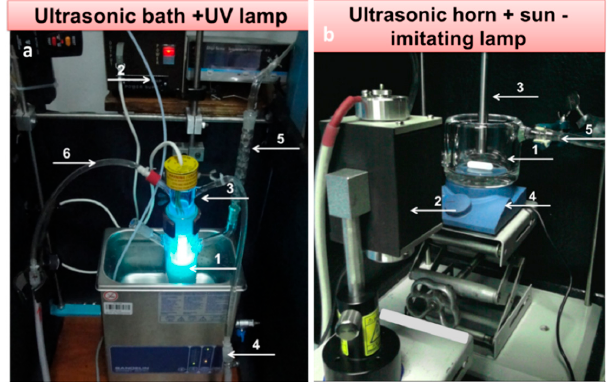
Figure 12. Different reaction setups for the sonophotodeposition synthesis: ( a ) US bath-UV lamp setup: (1) batch photoreactor, (2) argon line, (3) 6 W UV lamp, (4) ultrasonic bath, (5) reflux condenser (6) lamp cooling system; ( b ) US horn-Xe lamp setup: (1) photoreactor, (2) 150 W Xe lamp, (3) ultrasonic horn, (4) magnetic stirrer and (5) cooling system.